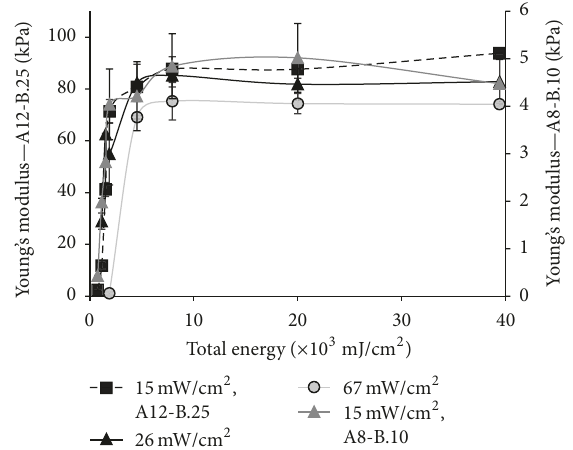
function of UV dose calculated as UV intensity multiplied by UV exposure